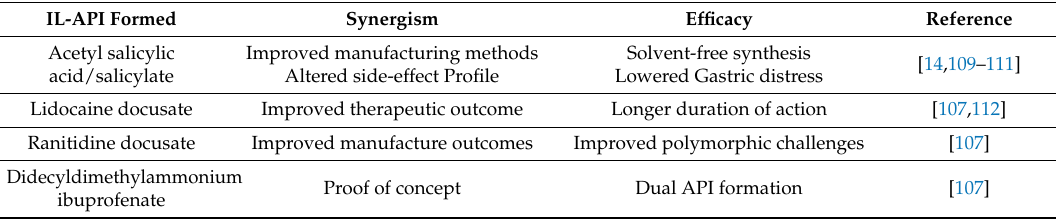
Table 4. The use of IL-APIs with beneficial delivery and therapeutic